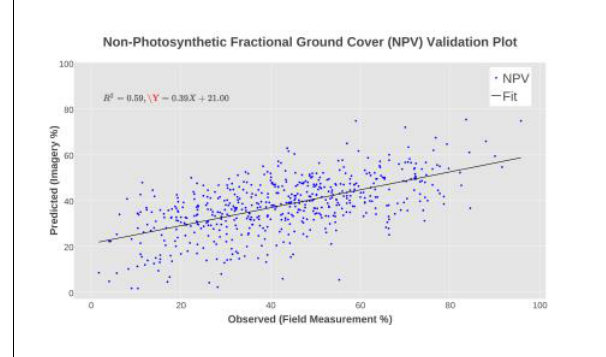
Figure 11. Field site measured NPV compared with coincident date LFGC derived NPV